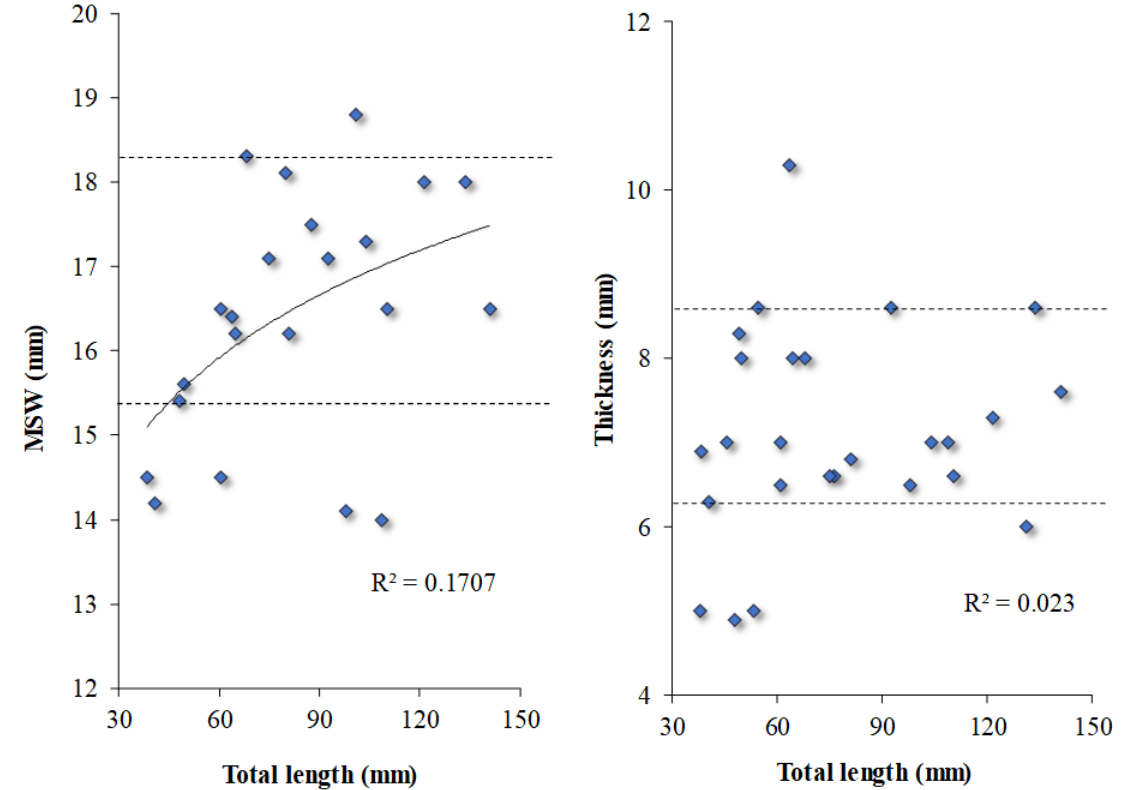
Figure 17. Left: biplot between the maximum length of the points and the minimum width of the stem (MSW). The dotted lines between 15.4 - 18.3 mm comprise 72% of MSW distribution (Q1 – Q3: 15.4 – 17.5 mm). Right: maximum length and maximum thickness of the points. The dotted line (2 mm) encompasses ~ 80% of the thickness, between 6.3 - 8.6 mm (Q1 – Q3: 6.5 – 8